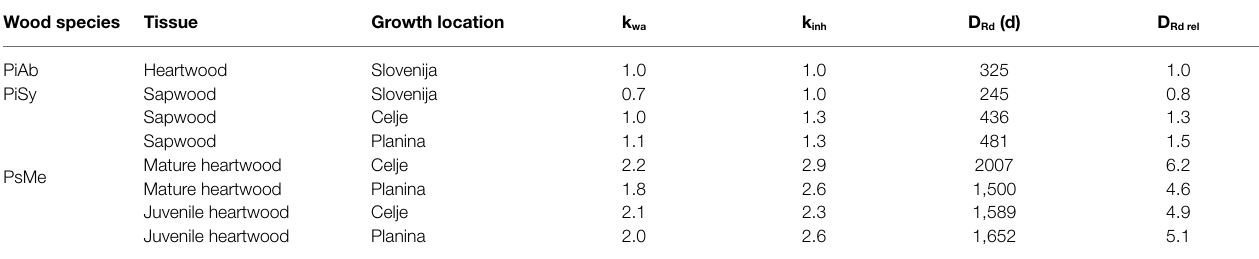
TABLE 3 | Factors that determine the service life of the wood. Wood species Tissue